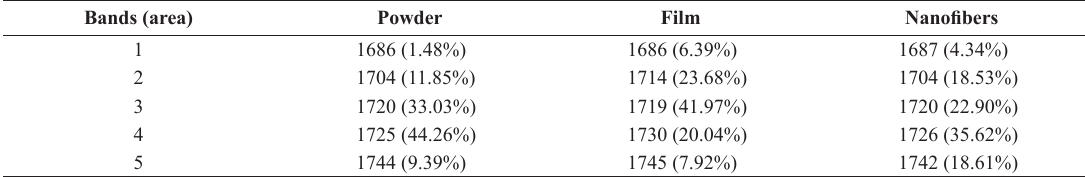
Table 2. FTIR peaks and their corresponding areas after deconvolution of carbonyl region. Bands (area) Powder